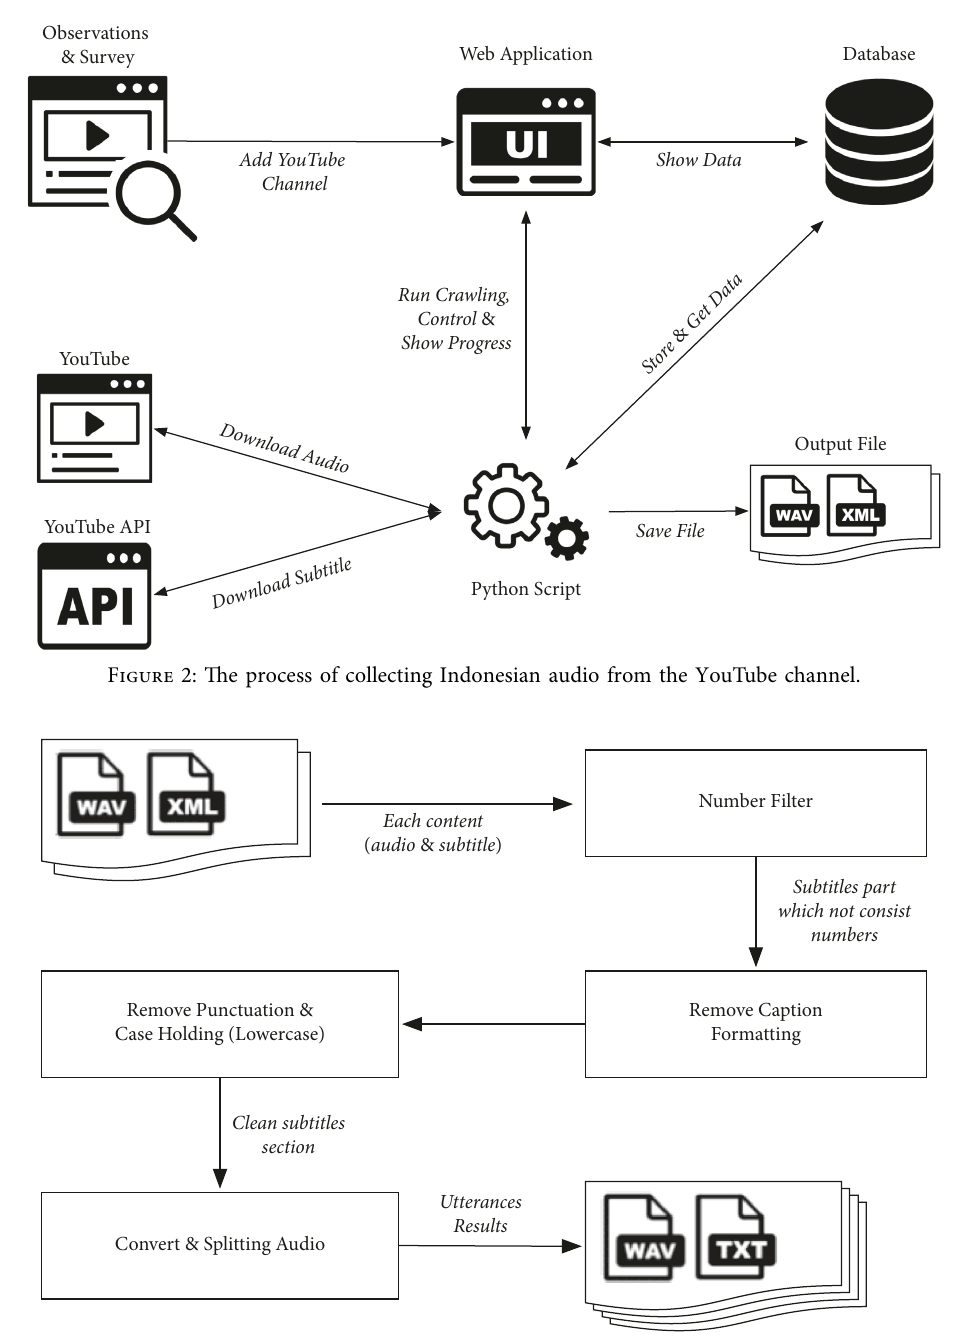
Figure 3: The data preparation process.